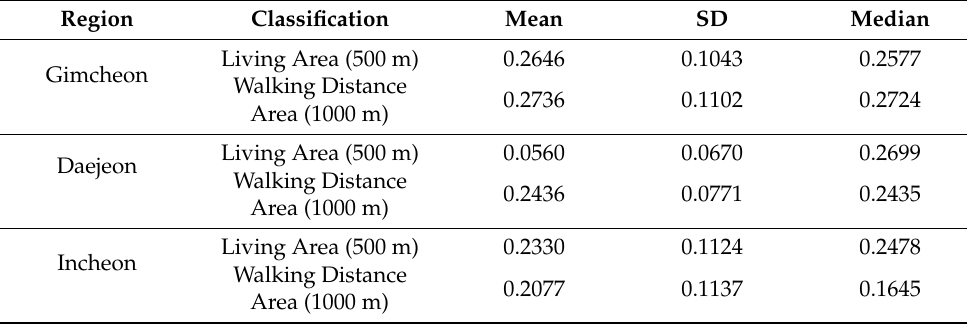
Table 2. NDVI analysis of participants’ living